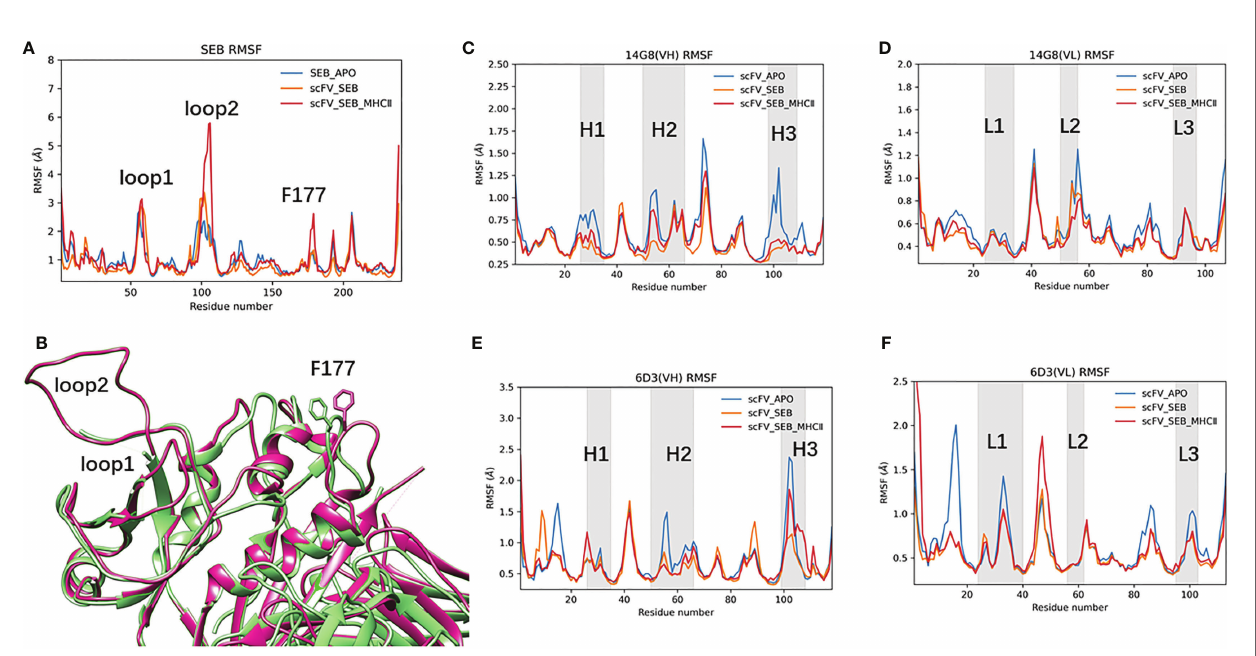
FIGURE 4 | Binding of Bispeci fi c scFV antibody on SEB leads to changes of RMSF for all interaction partners, illustrated by the change of RMSFs of different protein chains in three states: free state, MB102a-SEB complex, and MB102a-SEB-MHC II complex. (A) RMSF of SEB. (B) superimposing of the crystal structure of SEB (green ribbon) with the fi nal snapshot in MB102a-SEB complex (purple ribbon). (C) 14G8 VH chain. (D) 14G8 VL chain. (E) 6D3 VH chain. (F) 6D3 VL